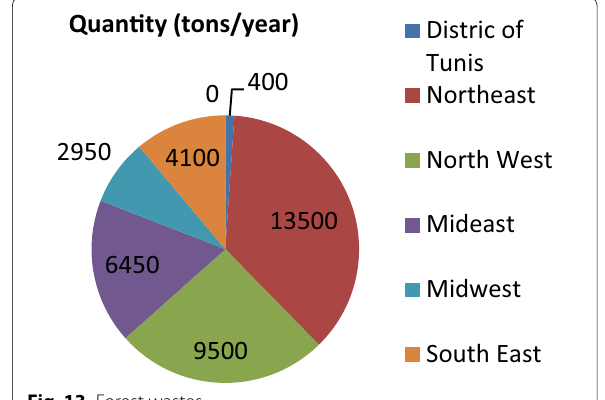
Fig. 13 Forest wastes